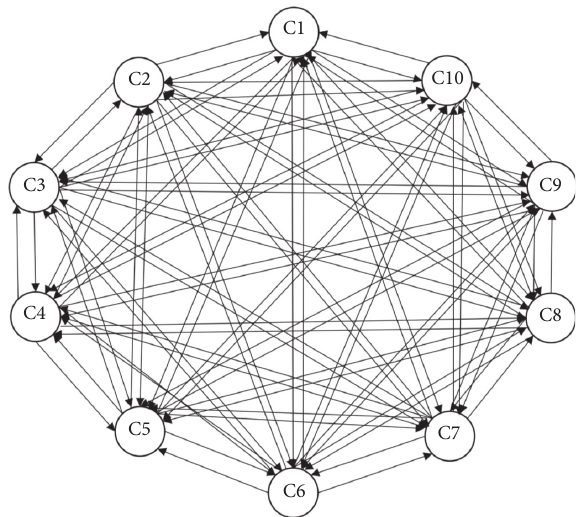
Figure 2: Fuzzy cognitive